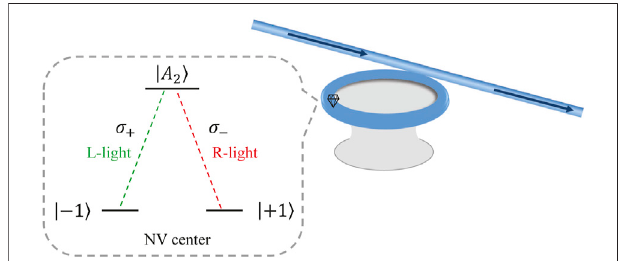
FIGURE 1 | Schematic diagram for a diamond NV center con fi ned in a MTR and energy-level diagram of a diamond NV center. The transitions | ∓ 1 〉 ↔ | A 〉 are resonantly coupled to the left-circularly and the right-circularly 2 polarized photons,